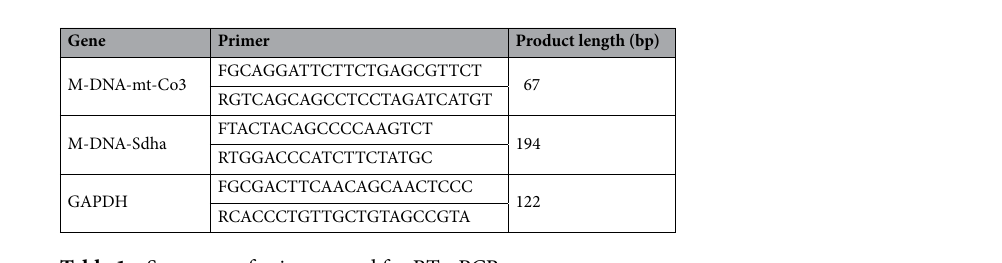
Table 1. Sequence of primers used for RT-qPCR